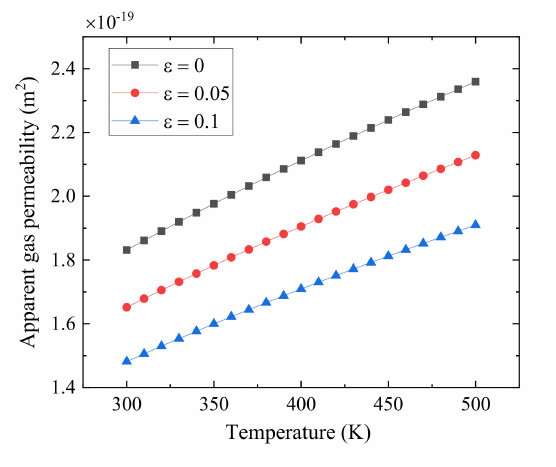
Figure 8. Plot of apparent permeability against temperature at different relative